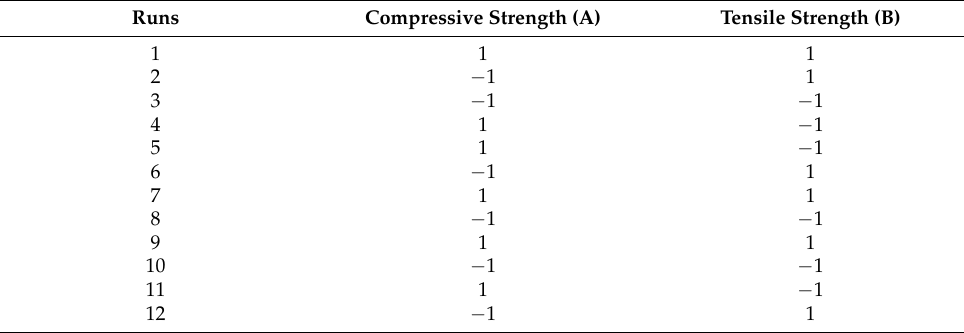
Table 10. Factorial identification by Plackett–Burman